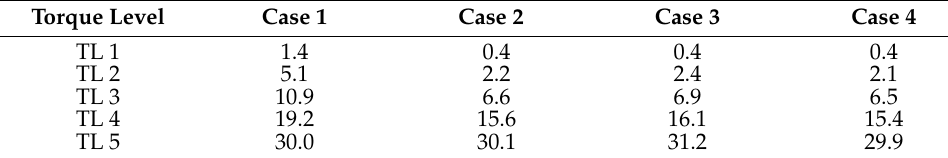
Table 6. The energy consumption for sit to stand (milliwatts).